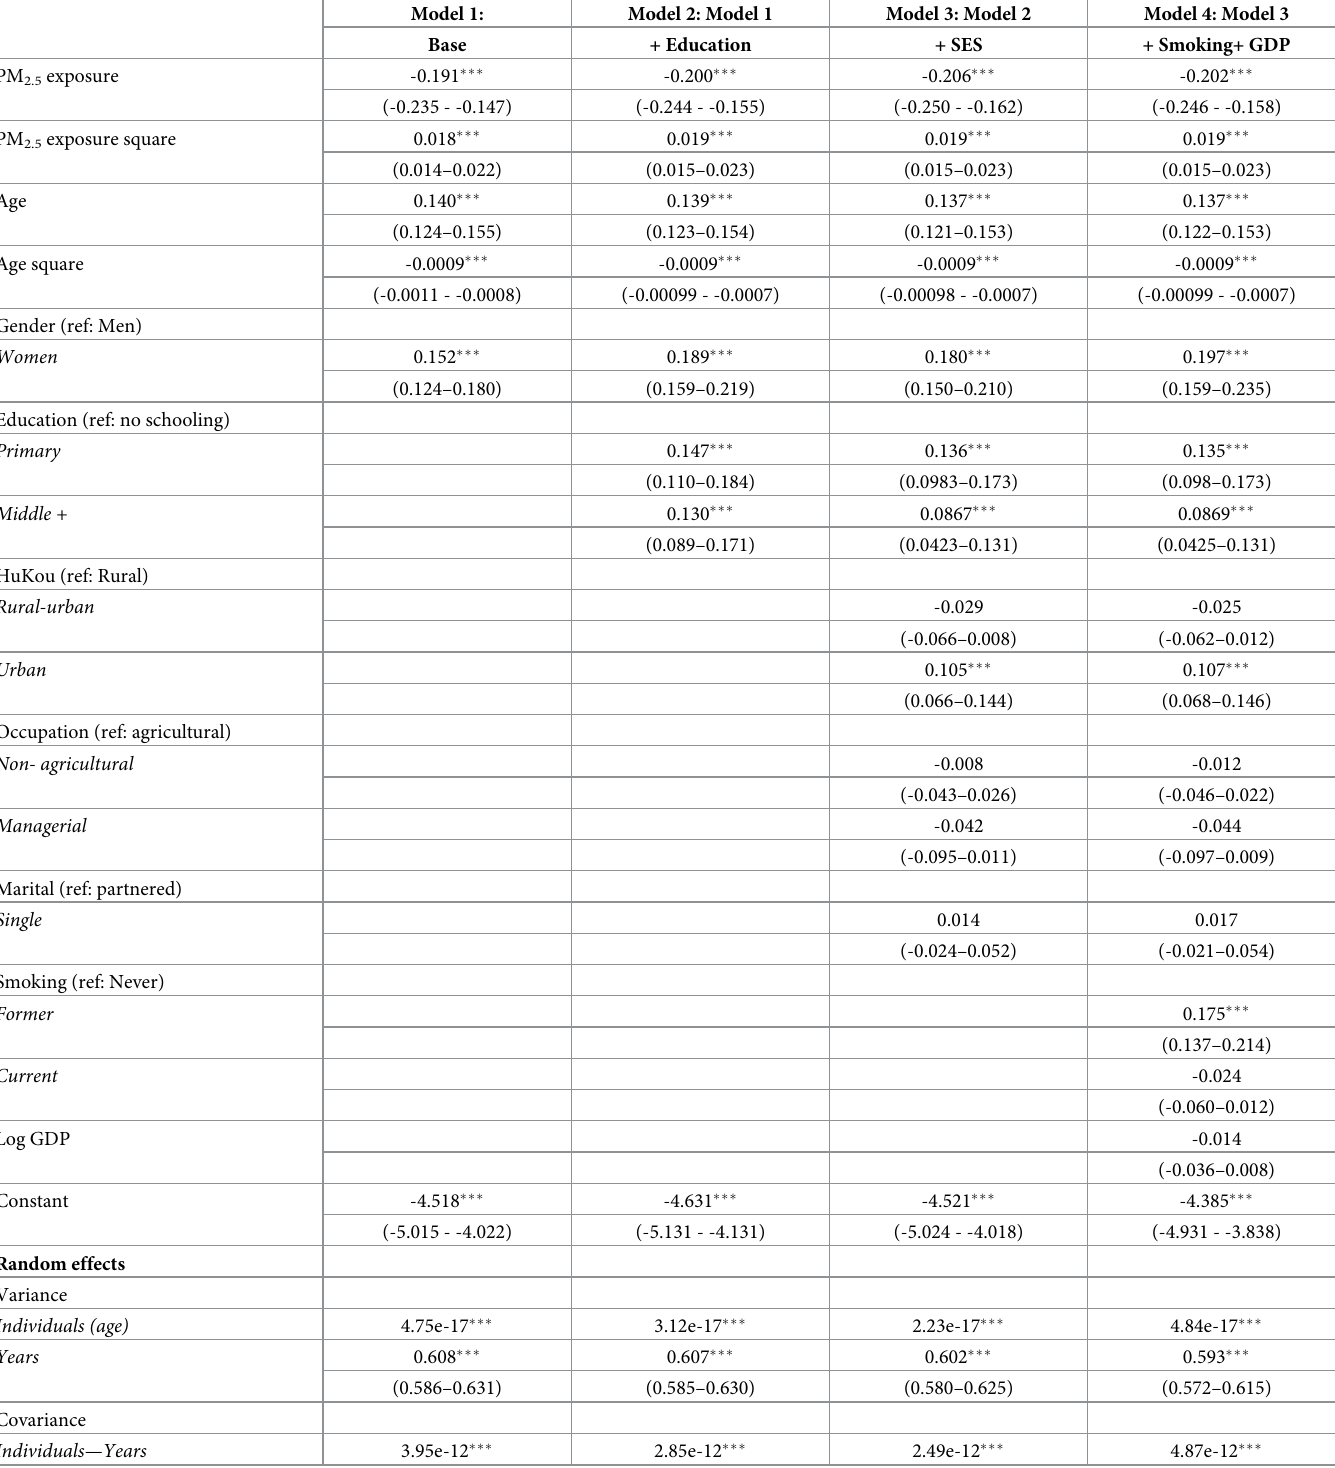
Table 4. Coefficients with 95% confidence intervals of growth curve models on the associations of 10 μg /m 3 increase in PM 2.5 exposure and its quadratic terms and covariates, with multimorbidity, CHARLS